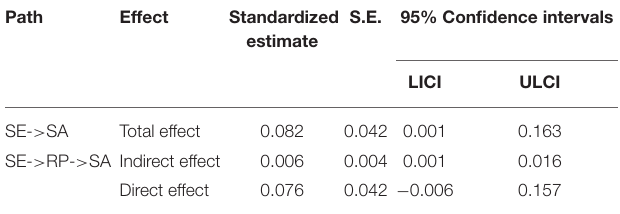
TABLE 7 | Regression test of moderating effect during pandemic ( N = 1511).